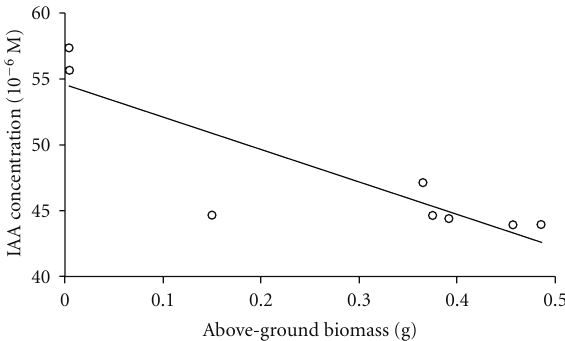
Figure 2: Relationship between IAA concentration and plant above-ground biomass ( y = − 24.35 x + 54.53, R 2 = 0.75, P = 0.005).